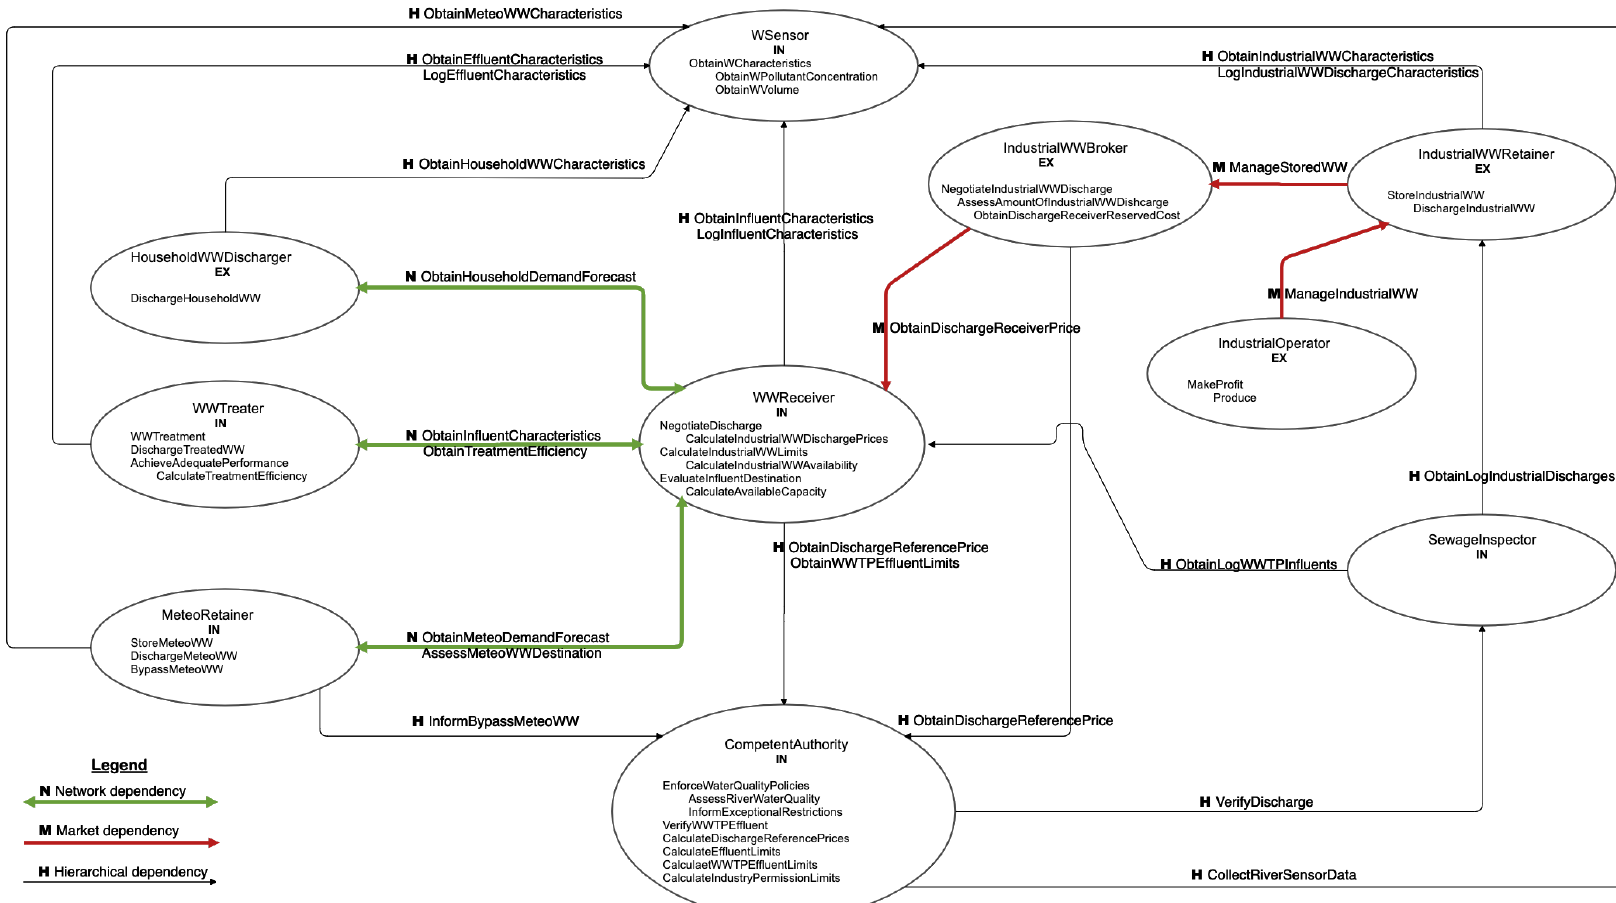
Figure 2. Diagram of the roles and role